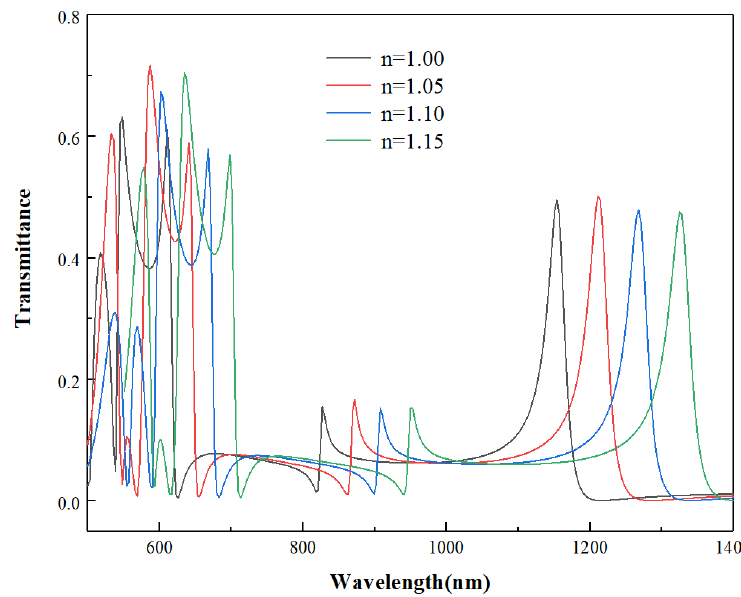
Figure 4. Transmission spectra of the waveguide structures with different refractive indices.